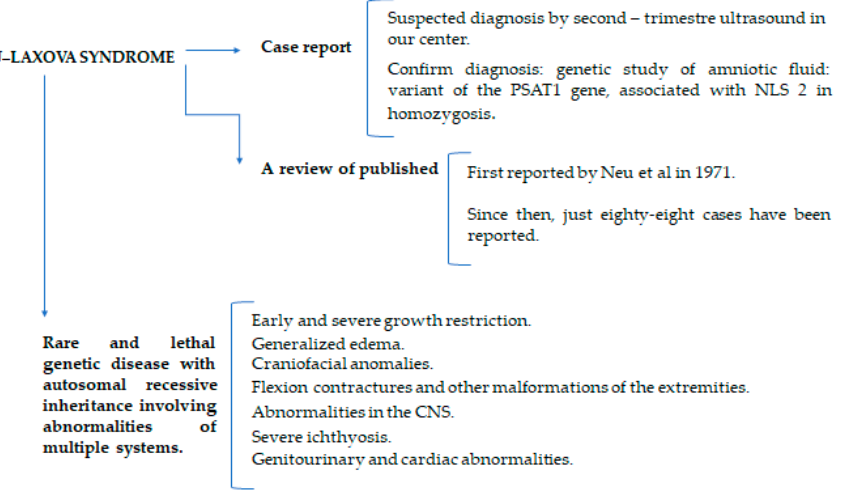
Figure 1. Summary of the main aspects discussed in the manuscript.